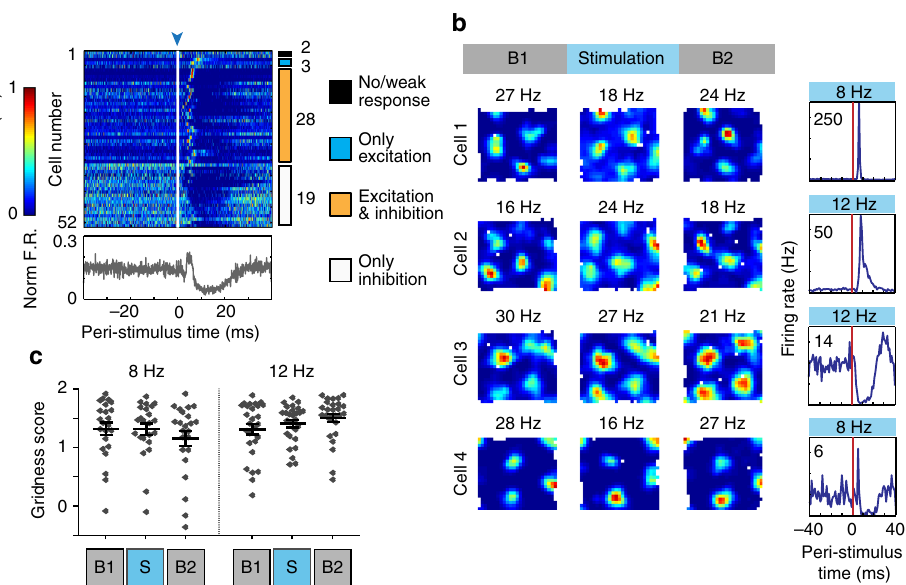
Fig. 7 Grid cells were inhibited by LIIP cell activation. a Peri-stimulus time plots for all recorded grid cells. Cells are ordered by the response category to optical LIIP activation with the number of cells in each category indicated to the right. Most recorded grid cells (50 of 52) responded to the optical stimulation, and the response typically included a sustained period of inhibition (47 of the 52 grid cells). The mean normalized fi ring rate over all grid cells is depicted below the plot, demonstrating a sustained window of inhibition. b Over the entire stimulation session, example grid cells show preservation of grid fi elds regardless of their response to the local circuit perturbation (indicated in the leftmost plot). Rate maps are color coded from blue (minimum fi ring rate) to red (maximum fi ring rate, provided above each plot). c Grid scores remained high during stimulation sessions [two-way ANOVA with repeated measures on one factor, n = 23 cells for 8 Hz, 29 cells for 12 Hz across 3 mice, F (2,96) = 2.416, p = 0.0946]. Plots show the mean ±